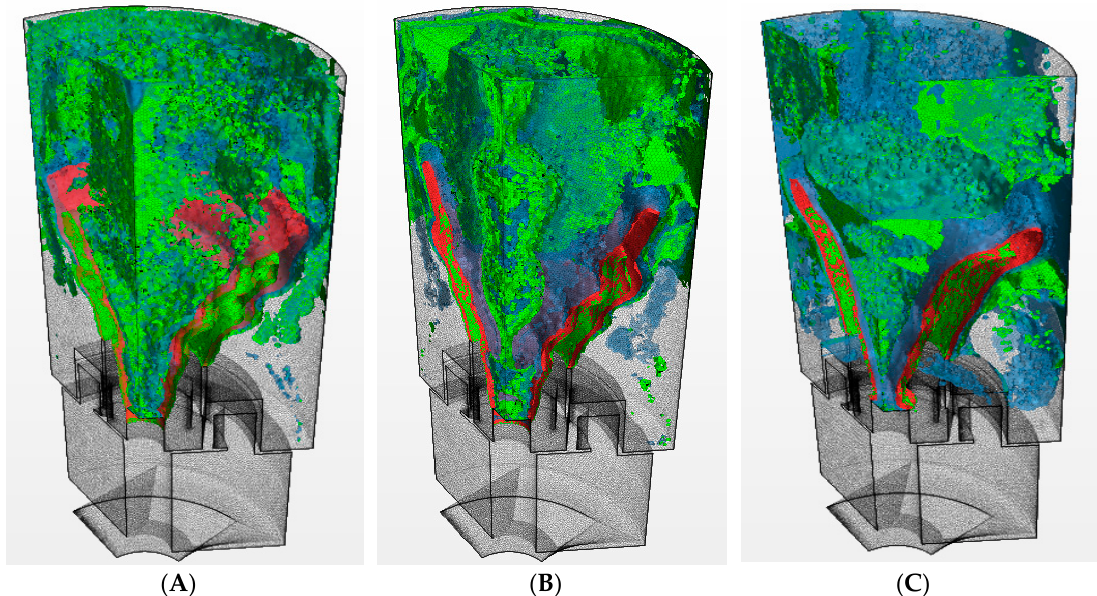
Figure 13. Isosurfaces (same opacities and thresholds) of the production of hydrogen (blue) through the destruction of ammonia (green) after the flame (red). Operating conditions: 900 kPa, 500 K. ( A ) 1450 K; ( B ) 1800 K; ( C ) adiabatic conditions.